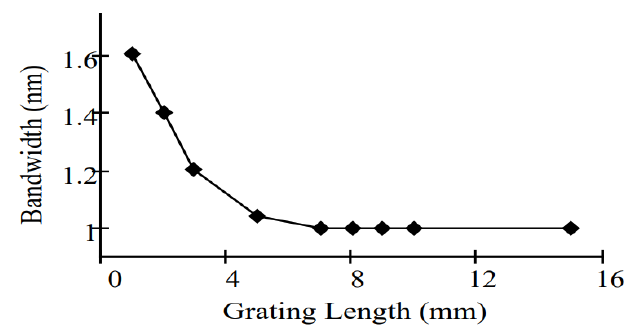
Figure 9. Relationship between FBG sensor bandwidth and grating length [15].